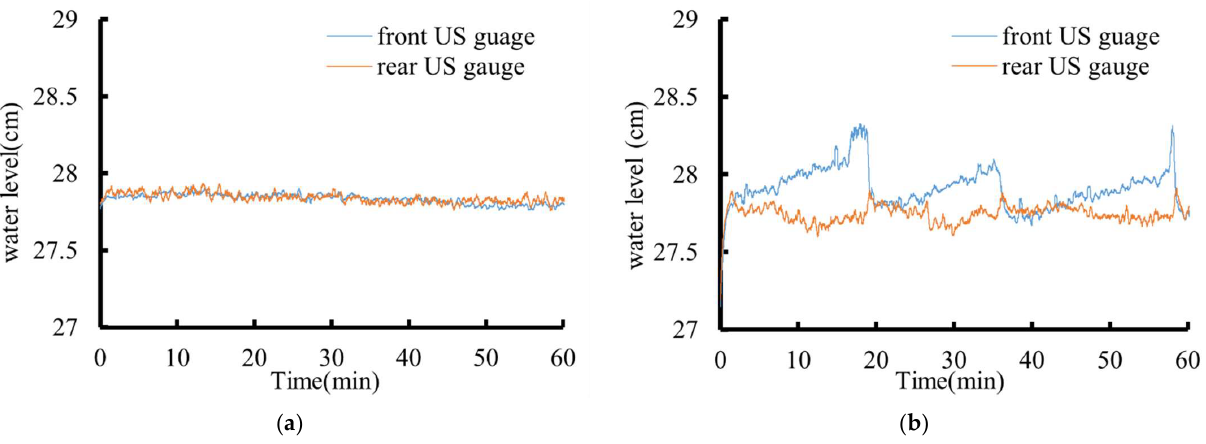
Figure 7. Time history of the water level captured by the ultrasonic distance sensors ( a ) without the presence of woody debris in test 2; ( b ) in the presence of woody debris in test